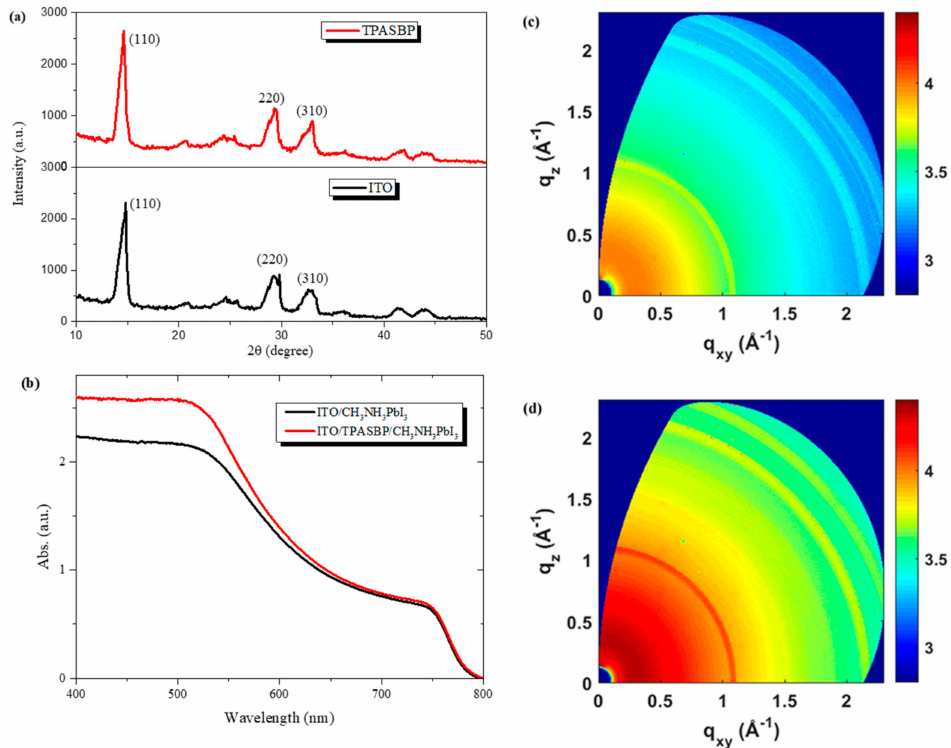
Figure 2. ( a ) X-ray di ff raction (XRD) patterns, and ( b ) UV–vis absorption spectra of CH 3 NH 3 PbI 3 films on ITO and TPASBP substrates, ( c ) and ( d ) two-dimensional grazing-incident wide-angle X-ray scattering (GIWAXS) patterns of CH 3 NH 3 PbI 3 films on ITO and TPASBP,